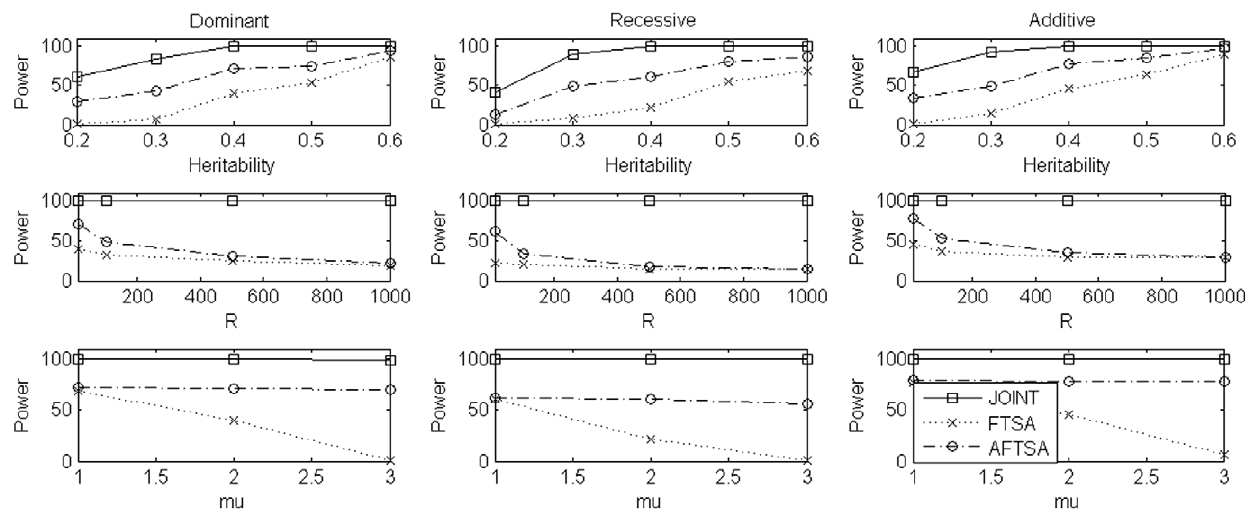
Figure 2. Power comparison under simulation set 2 when sample size is 600 trios. In the first row, we compare power of the three methods for different values of heritability under the three disease models while m =2 and the number of markers selected at the first stage is 10. In the second row, we compare power of the three methods for different numbers of markers selected at the first stage under the three disease models while m =2 and heritability is 0.05. In the third row, we compare power of the three methods for different values of m under the three disease models while heritability is 0.05 and the number of markers selected at the first stage is 10. In each case, we use 800 genomic markers to control for population stratification in the admixture screening test.